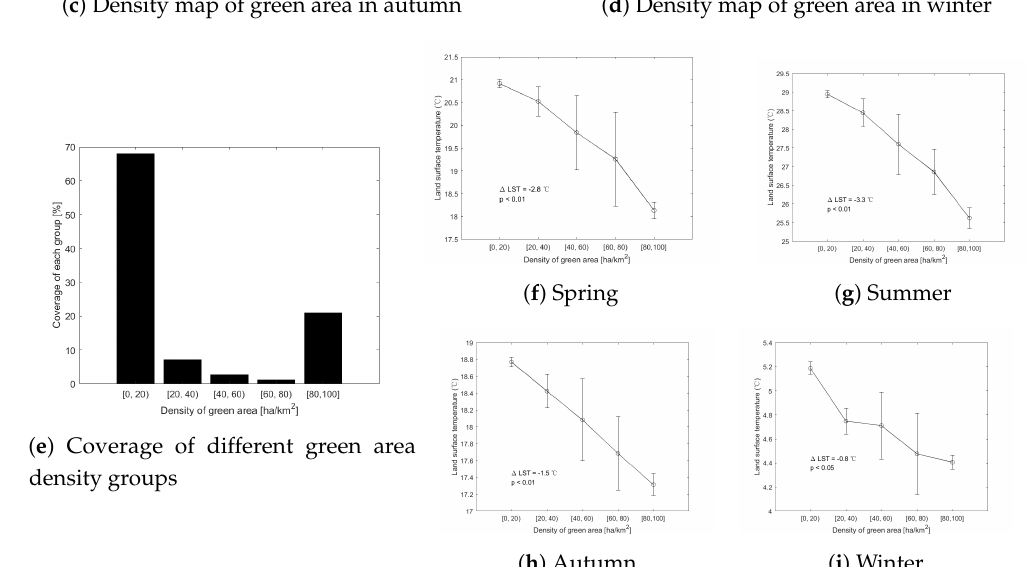
Figure 13. Density map of green area for four seasons in Paris. Different colored areas and sized circles indicate various temperatures ( ◦ C) and different density groups respectively. Figures ( f – i ) present the relationships between LST and density of green area with 95% confidence